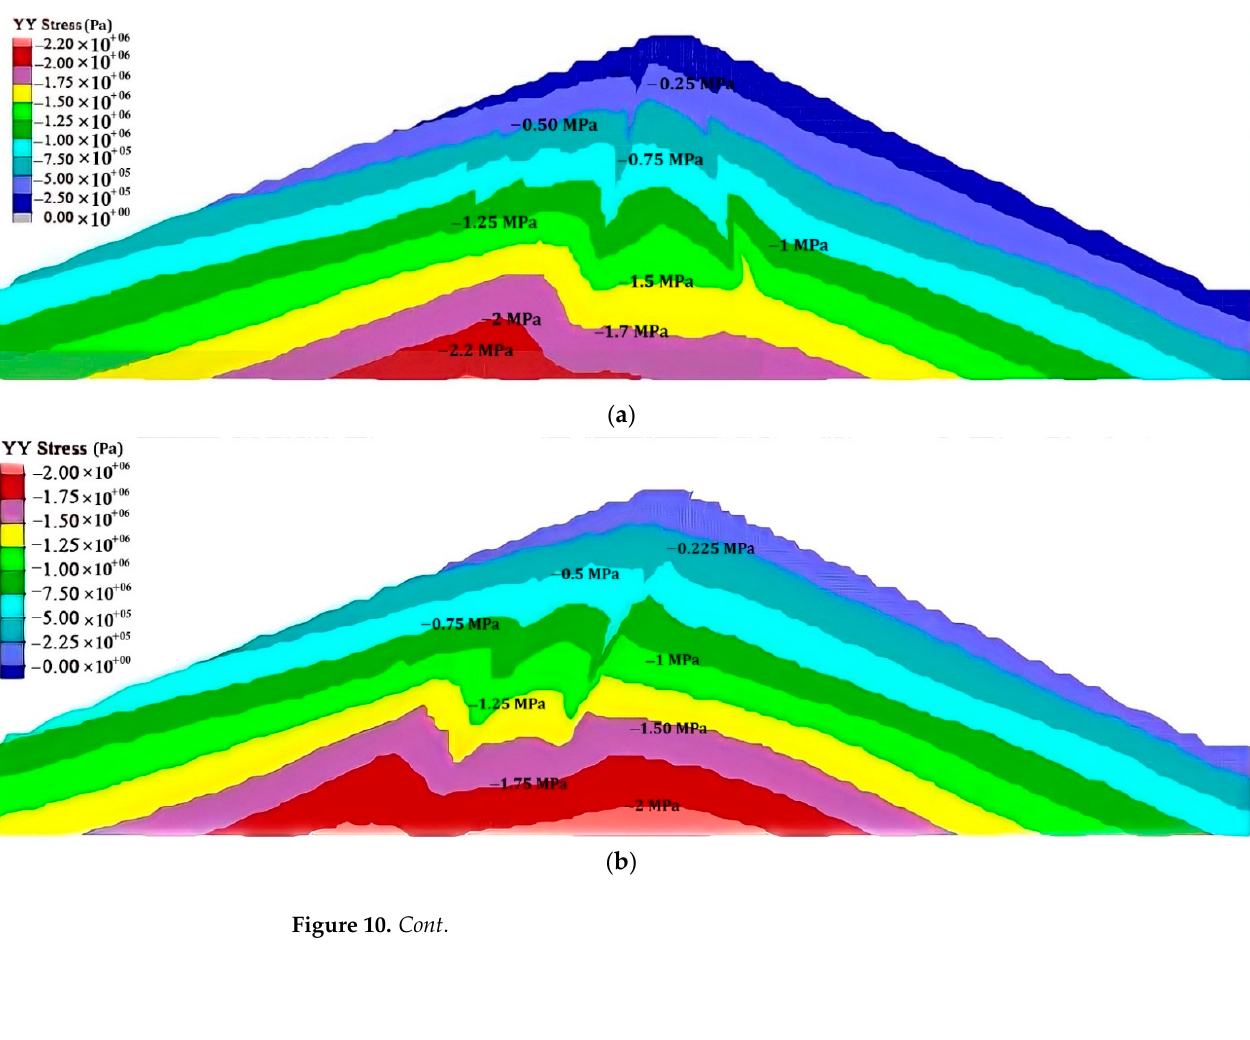
Figure 9. Induction acceleration in the dam’s crest.